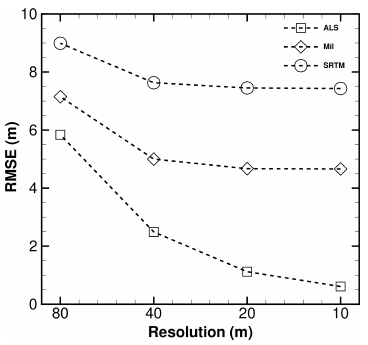
Figure 7. Impact of mesh resolution on